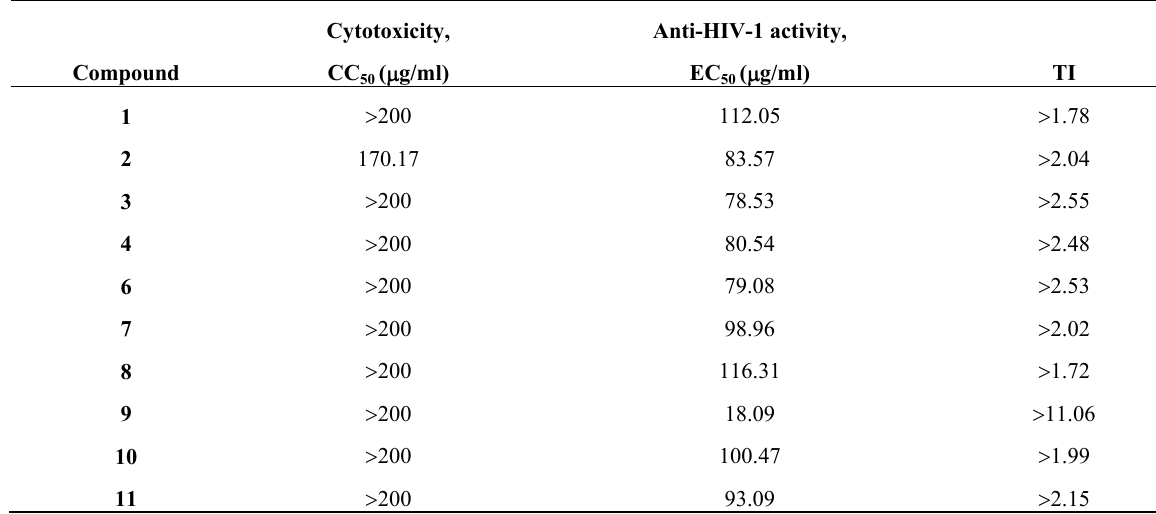
Table 3. Cytotoxicity and Anti-HIV-1 Activity of Compounds 1 − 4, 6 −